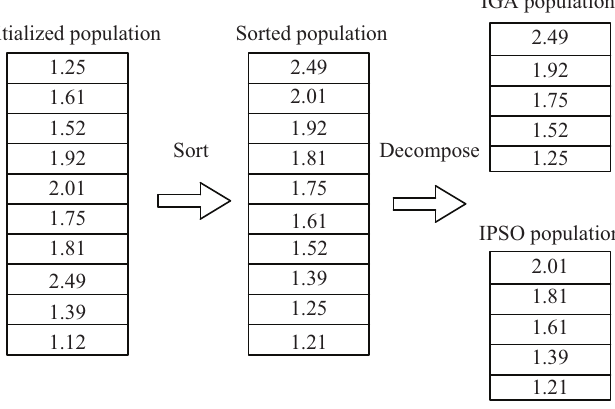
Figure 9. Parallel decomposition of the initial population.